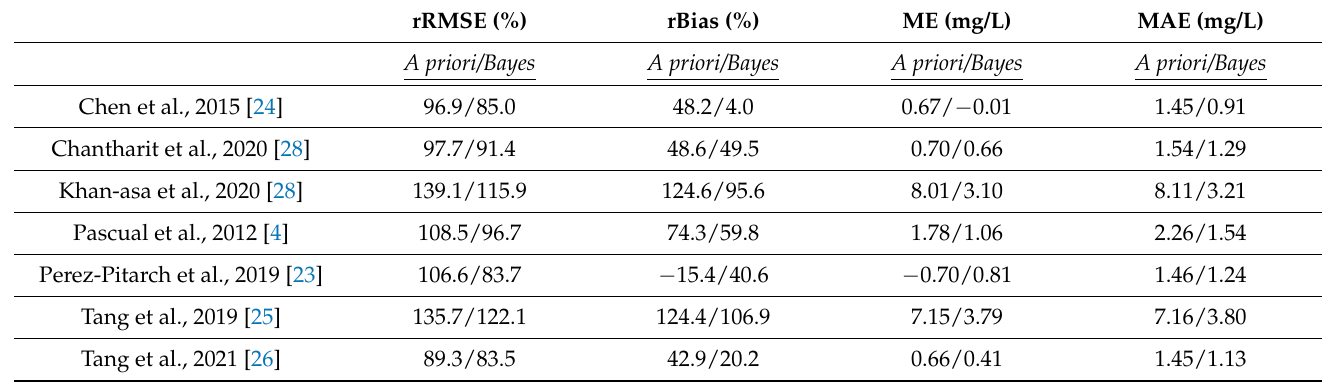
Table 3. Performance metrics of seven evaluated voriconazole